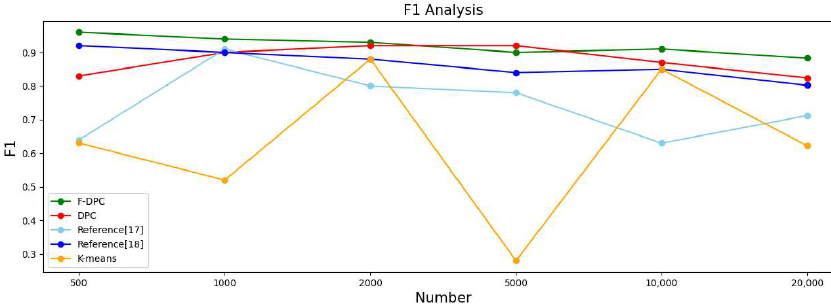
Figure 15. Line chart of evaluation index F1 [17,18].